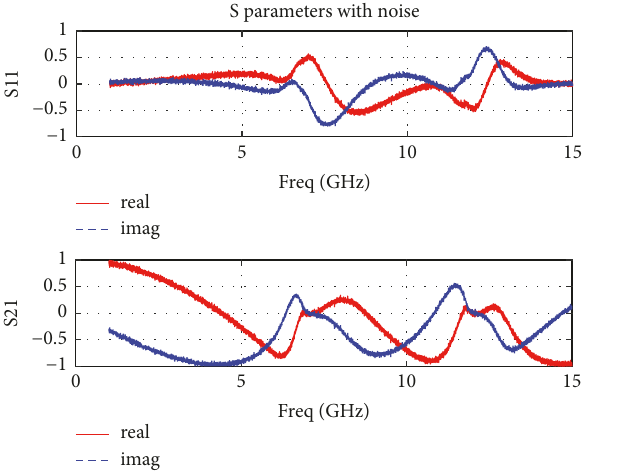
Figure 1: The Scattering parameters S11 and S21 with noise.